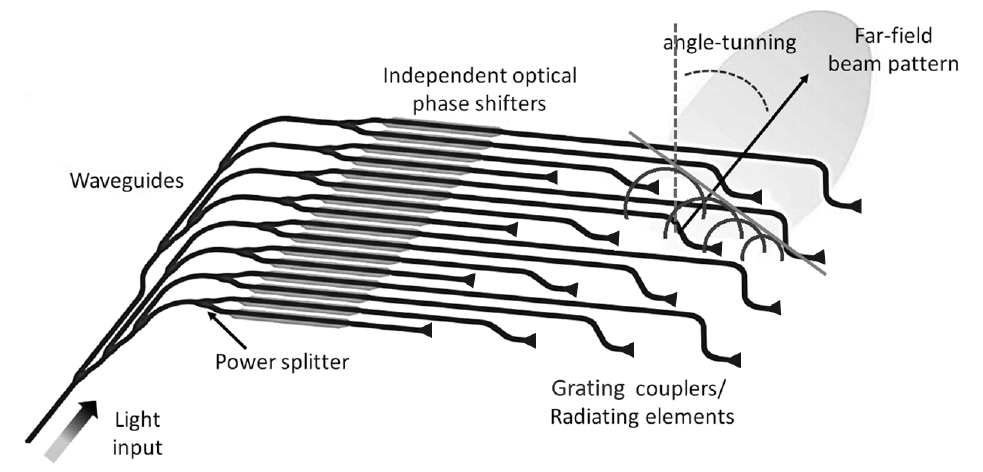
Figure 7. Schematic diagram of the working principle of an optical phased array (OPA): emitted fields from each antenna interfere to steer a far-field